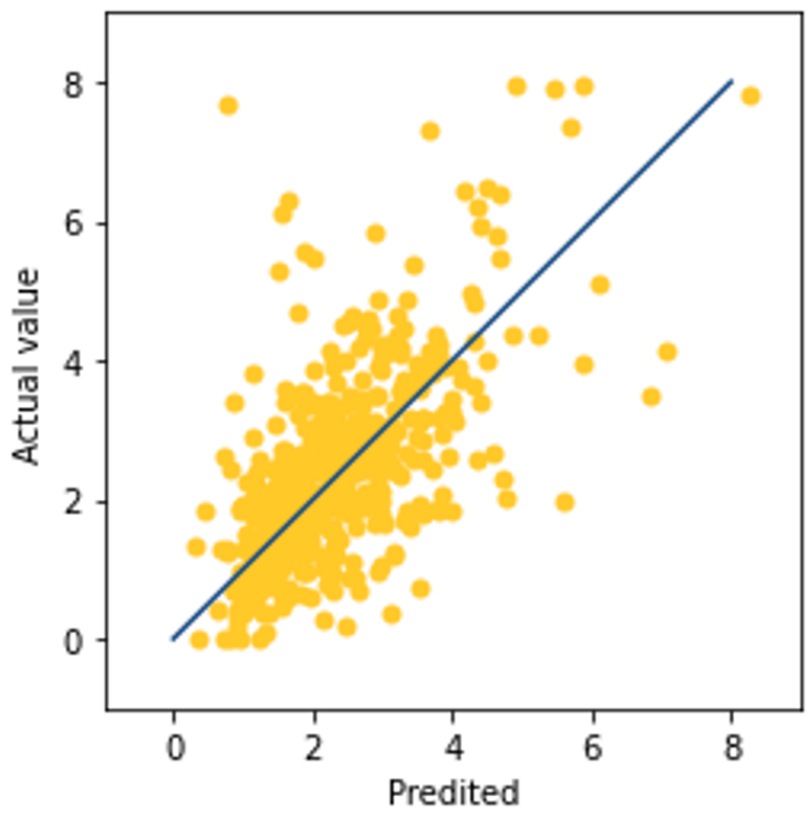
Figure 5. Scatterplot between predicted values and actual values.